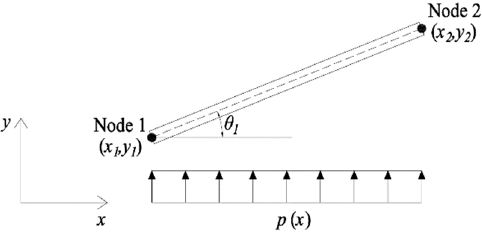
Figure 1. Analytical model of staggered seam assembly.